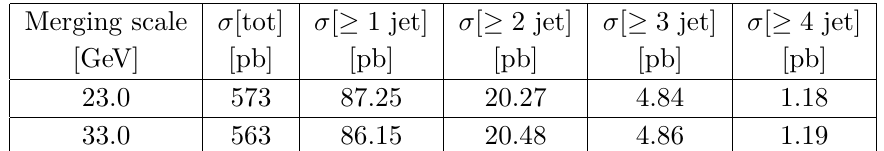
Table 1 . Multi-jet rates from the TMD merging merging algorithm as a function of the merging scale.